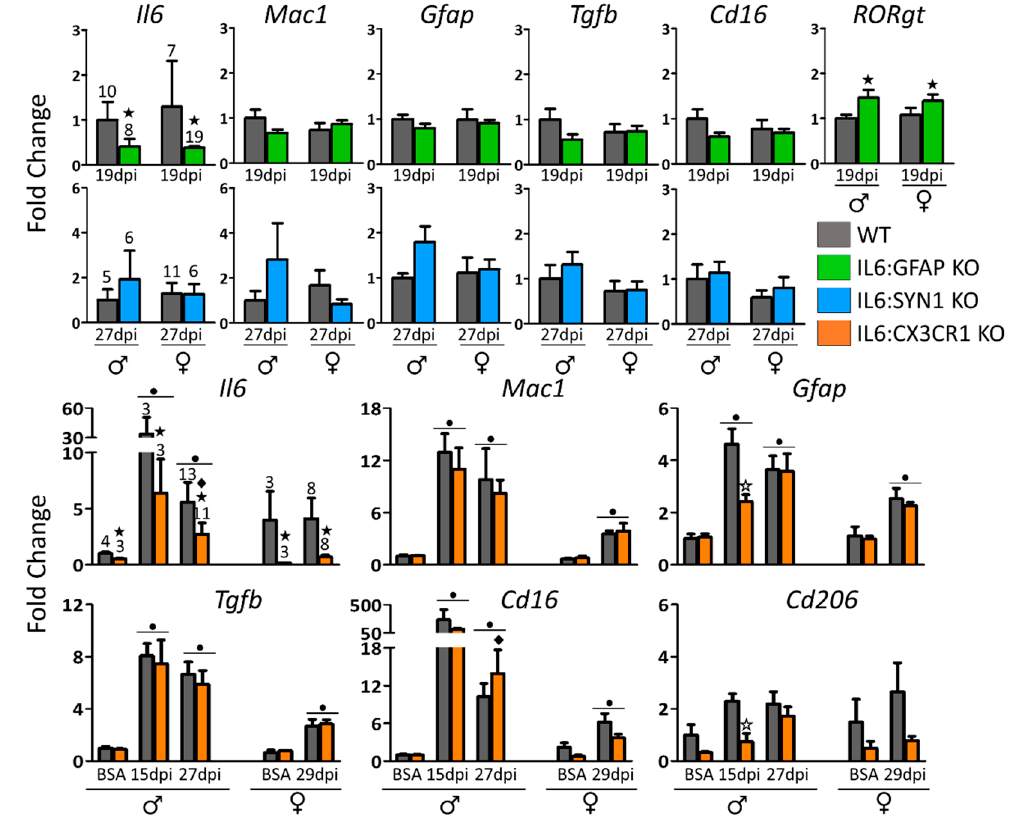
Figure 5. Analysis of inflammation-related gene expression. MOG 35-55 -immunized mice consistently presented with an increased expression of many of the genes studied both at 15 and 27–29 dpi ( bottom ). The Il6 expression levels were not as higher in MOG 35-55 -immunized IL6:GFAP KO and IL6:CX3CR1 KO mice as their MOG 35-55 -immunized controls. In contrast, they were similar between IL6:SYN1 KO and their control mice. Moreover, astrocytic ( top ), neuronal ( middle ), and microglial ( bottom ) Il6 deficiency plays a marginal and complex role in the regulation gliosis ( Mac1 and Gfap expression) and macrophage polarization profile ( Cd16 , Cd206, and Tgf β expression). Number of mice per group as indicated. All results were represented in MEAN ± SEM; ★ p ≤ 0.05 versus WT mice. ✩ p ≤ 0.05 versus Indicates a significant interaction WT mice at 15 dpi only. p ≤ 0.05 versus BSA-immunized mice . between factors.